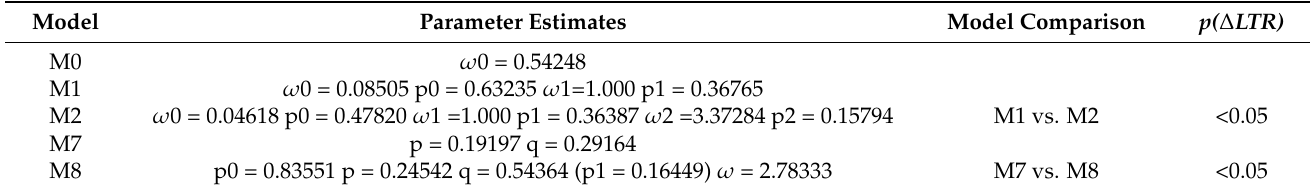
Table 2. Results of PAML analyses testing for selection on classical MHC genes.